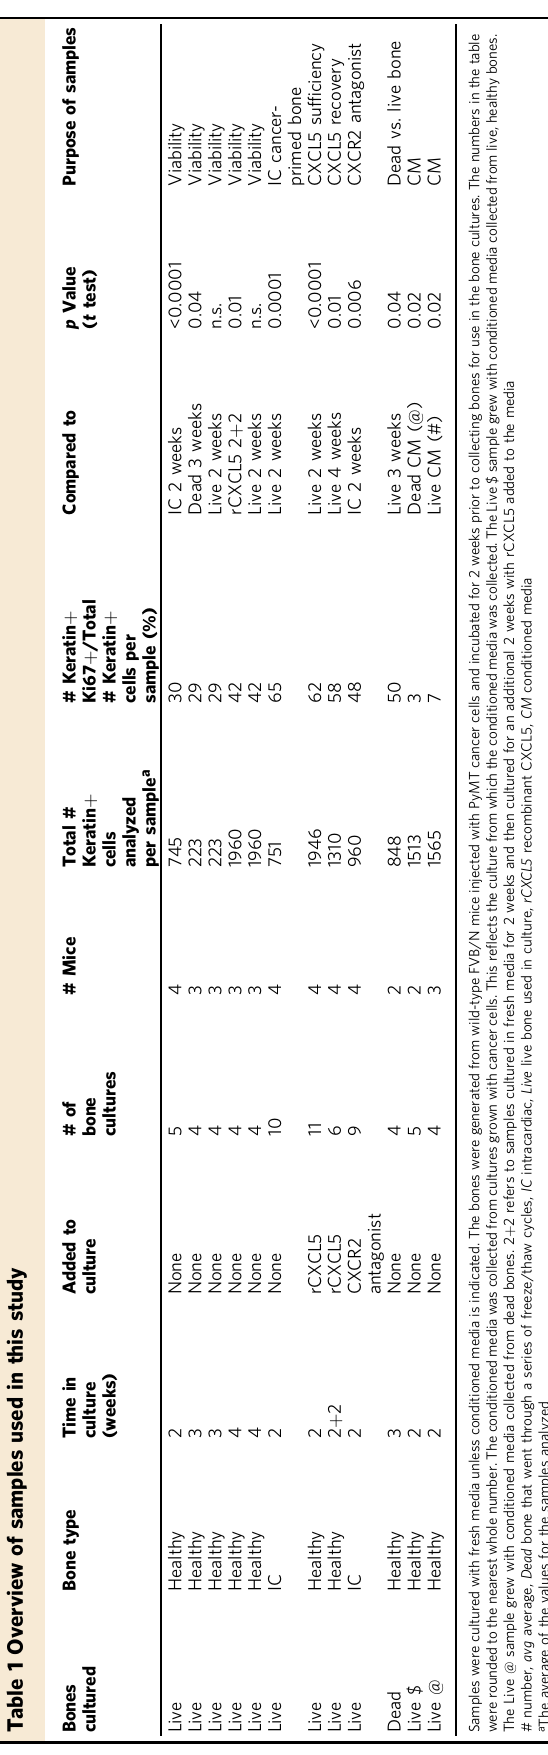
Methods Mice . The mouse models used in this study included the following transgenic mouse line: FVB. FVB mice were acquired from Harlan Laboratories, Inc. (now Envigo). All experiments in Table 1 used bones from FVB immunocompetent mice. Ethical animal usage . Mice used in this study were maintained under pathogen- free conditions in the University of Notre Dame Freimann Life Sciences Center. Animal experiments were conducted with approval from the University of Notre Dame Institutional Animal Care and Use Committee (IACUC) for the ethical treatment of animals (protocol # 15-10-2724). Cell line and cell culture . All cancer cell lines and co-cultures were carefully maintained in culture under sterile conditions at 37 °C and grown in 5% CO 2 using standard culture media containing Dulbecco ’ s modi fi ed Eagle ’ s medium (DMEM) H21 (Sigma, cat. # D5648) with 10% fetal bovine serum (FBS; JR Scienti fi c, cat. # 43640). For cancer cells, we used a mouse mammary epithelial cancer cell line derived from a bone metastasis from the MMTV-PyMT mouse model (source: Conor Lynch) 74 . These cells were selected for their ability to metastasize to bone. The PyMT cells express a luciferase reporter gene. Our cell line was authenticated prior to the initial experiments using short tandem repeat pro fi les (Genetica cell line testing), tested negative for mycoplasma contamination using a mycoplasma detection kit (InvivoGen, cat. # rep-pt1), and checked regularly for preservation of their typical morphology and behavior. Bone culture . For ex vivo bone cultures used in Table 1, femurs and tibiae were collected from healthy or tumor-bearing FVB/N mice and transplants, cut in half at the mid-diaphysis, cleaned to remove all connective tissue by cutting away the muscle and ligaments around the bone and by using clean gauze to remove the remaining connective tissue attached to the bone, pierced to form a hole at the epiphysis with a 25-gauge needle, and immediately placed into 12-well low-cell- binding plates (Thermo Scienti fi c #145385) with 2mL of culture media (DMEM H21 with 10% FBS and 1% antibiotics (Sigma #P4458) per well. Cancer cells (2.5× 10 5 cells) were resuspended in 10 μ L of culture media and carefully injected into the bone marrow through the open end of the diaphysis with a 27-gauge needle. The number of breast cancer cells (2.5 ×10 5 ) injected into the mouse bones for ex vivo bone cultures was chosen because it is the number of cells injected into mouse tibiae for in vivo intratibial injections 75 . After injection, the bones grew in culture for 2 – 4 weeks at 37°C and 5% CO 2 in the 12-well low-cell-binding tissue culture plates. Half of the culture media from each bone culture was replaced daily with fresh media to supply nutrients for the bone, marrow, and cancer cells. Half of the original media, or conditioned media, remained in each well to maintain proteins and other factors secreted into the media by the bone, marrow, and cancer cells. After culturing for the indicated time points, the bone samples were fi xed overnight in 4% paraformaldehyde (PFA) at 4°C, and stored the following day in 70% ethanol. For conditioned media experiments, half of the culture media from each bone culture was replaced daily with a mixture of a 1:1 ratio of fresh media and conditioned media from a donor plate. For rCXCL5 and antCXCR2 experiments, half of the media was replaced daily